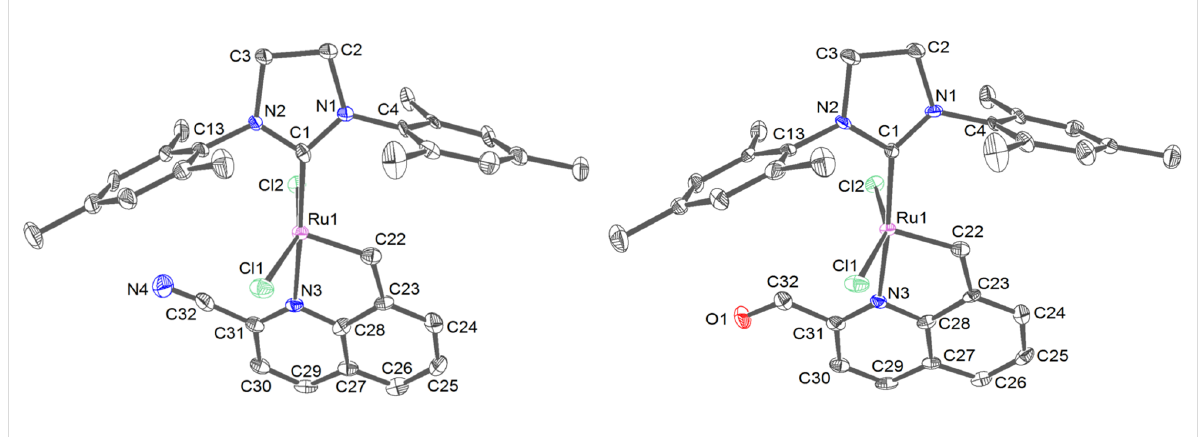
Figure 2: ADPs (atomic displacement parameters) and atoms labeling of the first molecule in the asymmetric part for 14 (left) and 15 (right). Thermal ellipsoids at 50% level of probability. Hydrogen atoms were omitted for clarity.